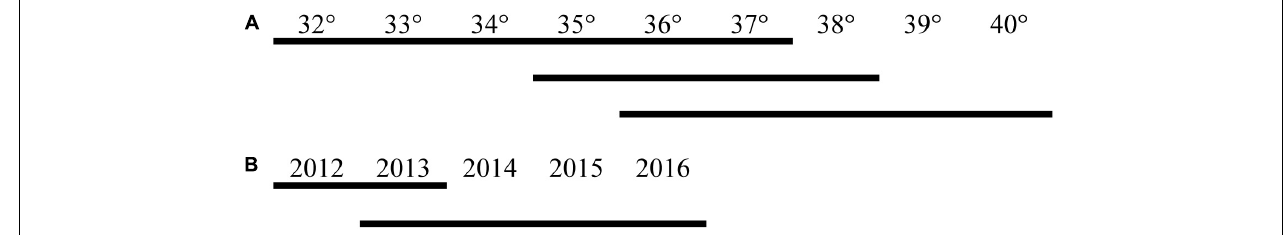
FIGURE 3 | Tukey’s pairwise multiple comparisons ( α = 0.05) illustrating consecutive latitudes (A) and years (B) for which contiguous lines indicate non-significant differences in fishing effort.